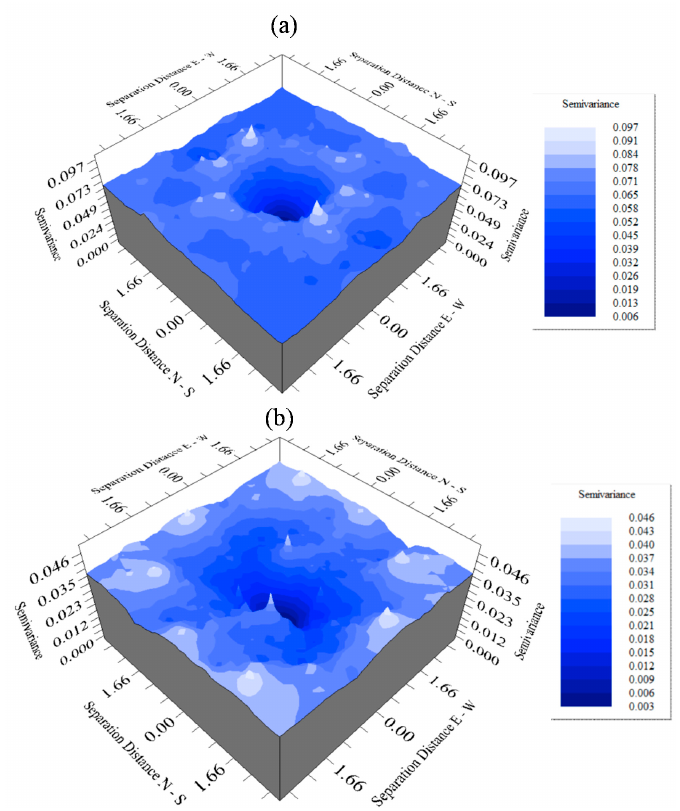
Figure 3. Surface variogram maps of throughfall (mm) in west-east (W-E) and north-south (N-S) directions, calculated for the ( a ) leafed and ( b ) leafless periods. Forests 2020 , 11 , x FOR PEER REVIEW